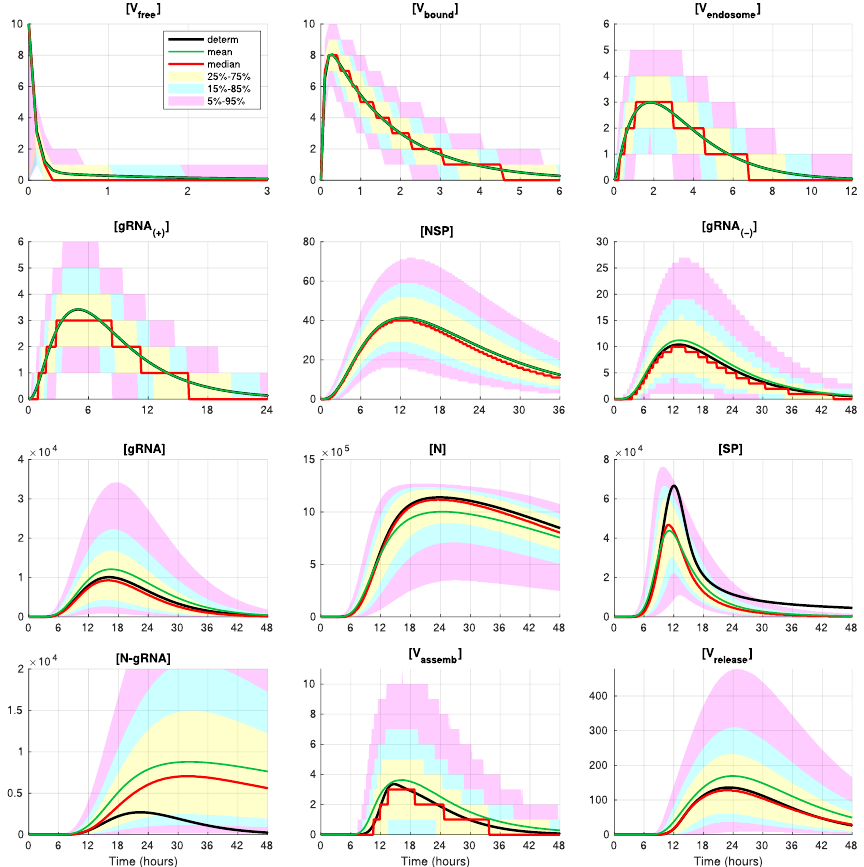
Figure 5. Evolution of the confidence intervals for all 12 components participating in the SARS-CoV-2 replication for [ V free ]( 0 ) = 10. The green, red, and black lines indicate the mean, median, and the deterministic solution,